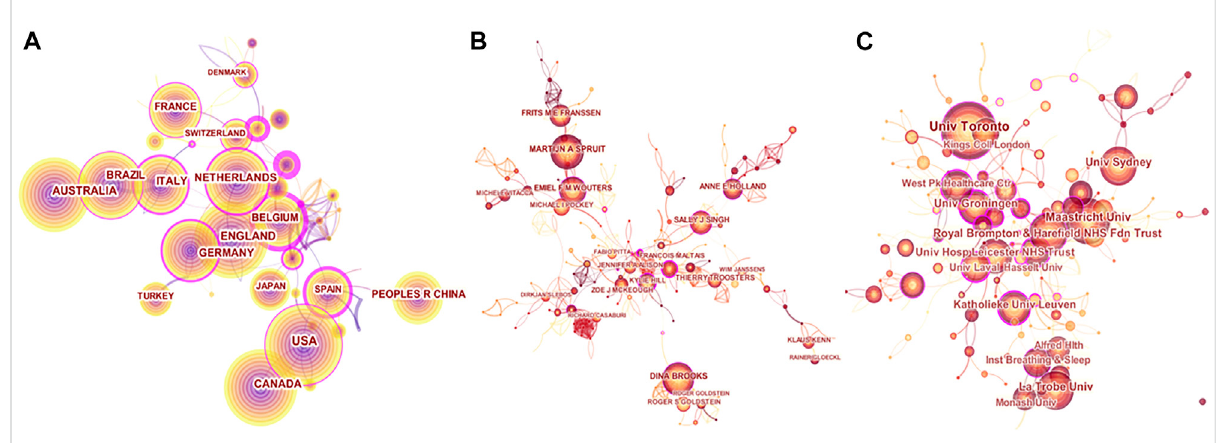
FIGURE 3 Cooperation map (A) . Co-countries (B) . Co-authors (C) . Co-institutions in the studies of the COPD and Exercise Therapy. Figures 3A – C are used by